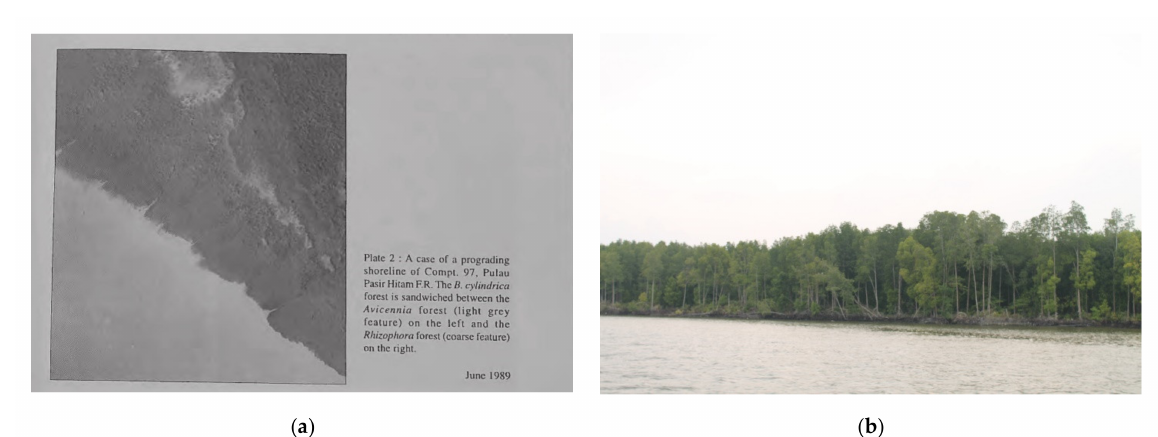
Figure 6. ( a ) Excerpt from “A Working Plan for Matang Mangrove Forest Reserve Perak, 1995 (fourth revision) by G.B. Keong”—Mangrove forest photographed at Pulau Pasir Hitam, Matang, Perak in 1989; ( b ) Photograph of mangrove forest at Matang, Perak in 2018 (Source: © Giovanna Wolswijk).